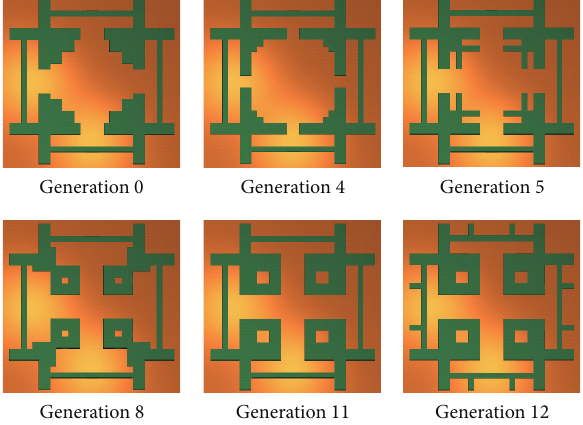
Figure 4: Evolution process—Case